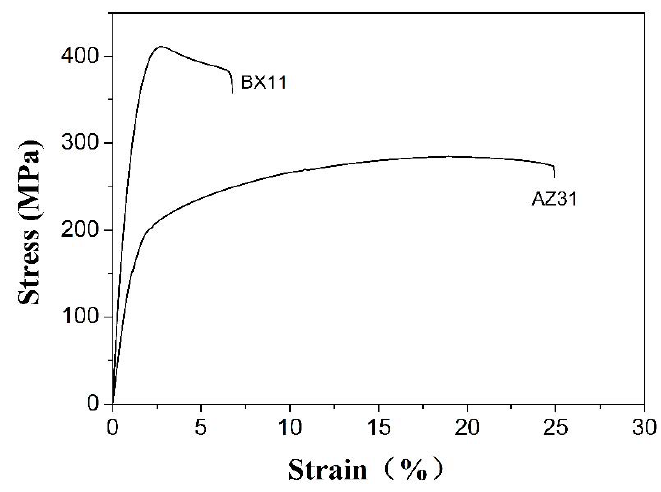
Figure 5. Typical tensile stress–strain curves of the as-extruded BX11 alloy compared with AZ31 [13].